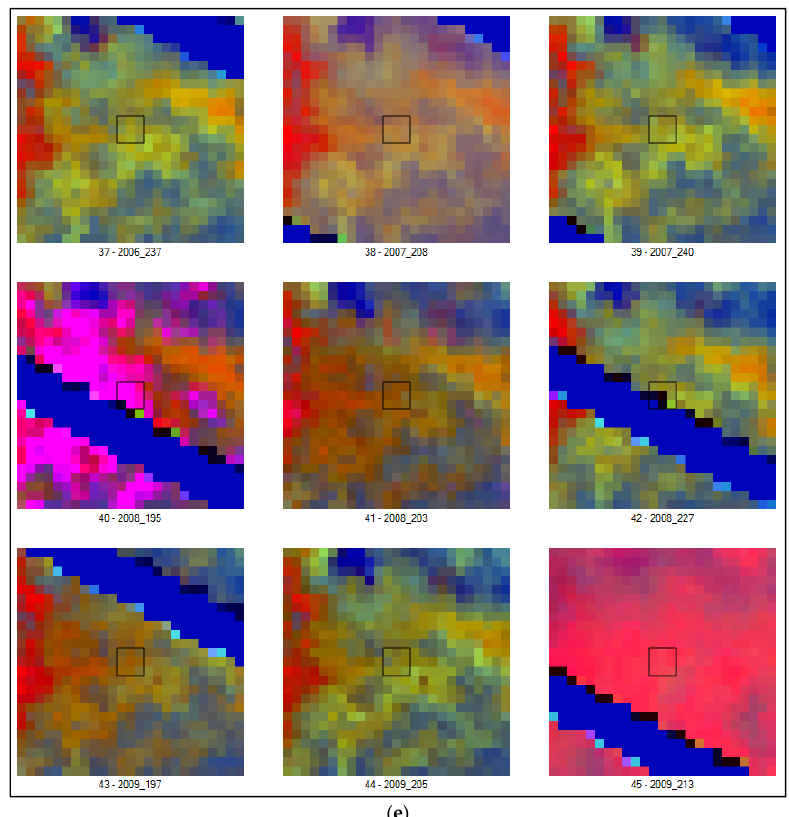
Figure A1. A 2008 Annual Variability patch generated by LandTrendr at Mount Rainier National Park. ( a ) Photo collected during field validation. Photo credit: NPS/Catharine Copass (2016). ( b ) Pre-disturbance 2006 aerial photo as viewed in Google Earth™. ( c ) Post-disturbance 2009 aerial photo as viewed in Google Earth™. ( d ) TimeSync spectral trajectory of nine pixels around patch centroid. ( e ) Part of the series of tasseled-cap image chips covering pre- and post-disturbance years as viewed in TimeSync. Dark blue streaks in ( e ) correspond to Landsat 7 missing scan lines, magenta colors correspond to snow and bright red colors denote clouds.